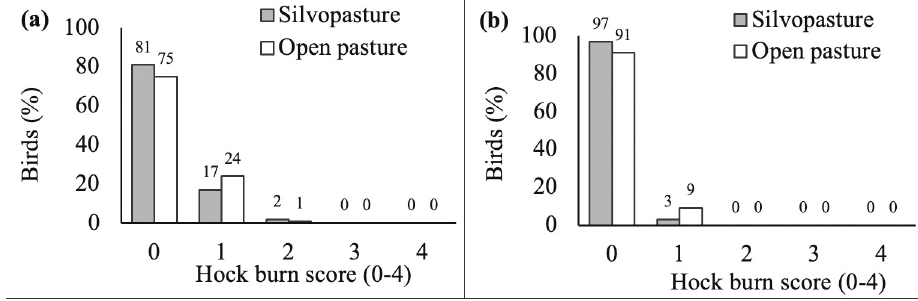
Fig 4. Percentage of birds with hock burn scores 0–4 in the silvopasture and open pasture treatments. (a) On day 39 of age in Experiment 1 (n = 159). (b) On day 38 of age in Experiment 2 (n =